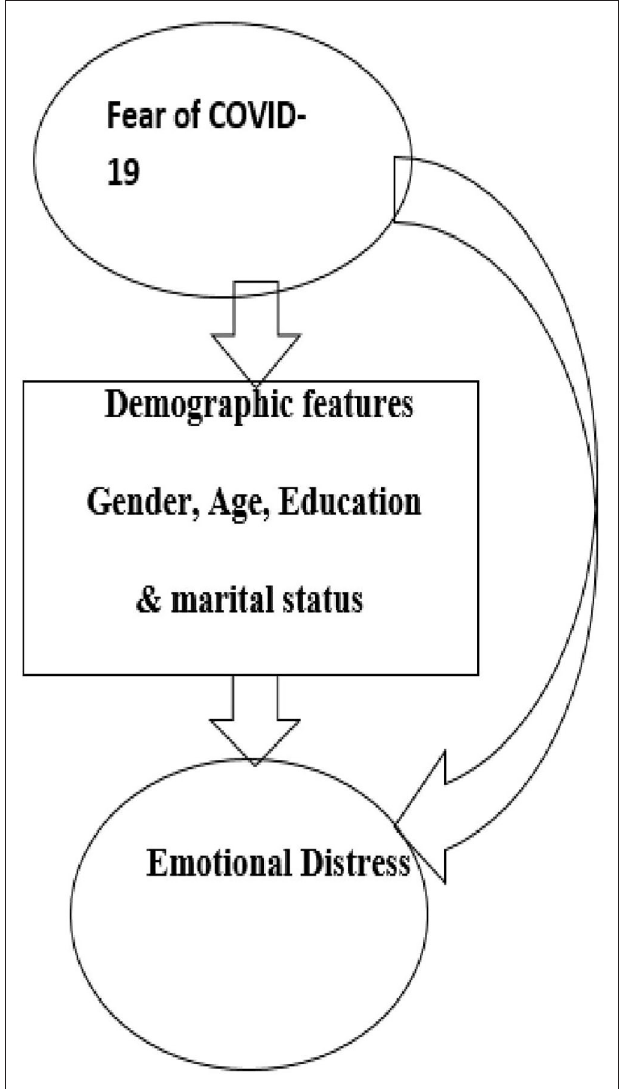
FIGURE 1 | Representation of proposed model of this study.